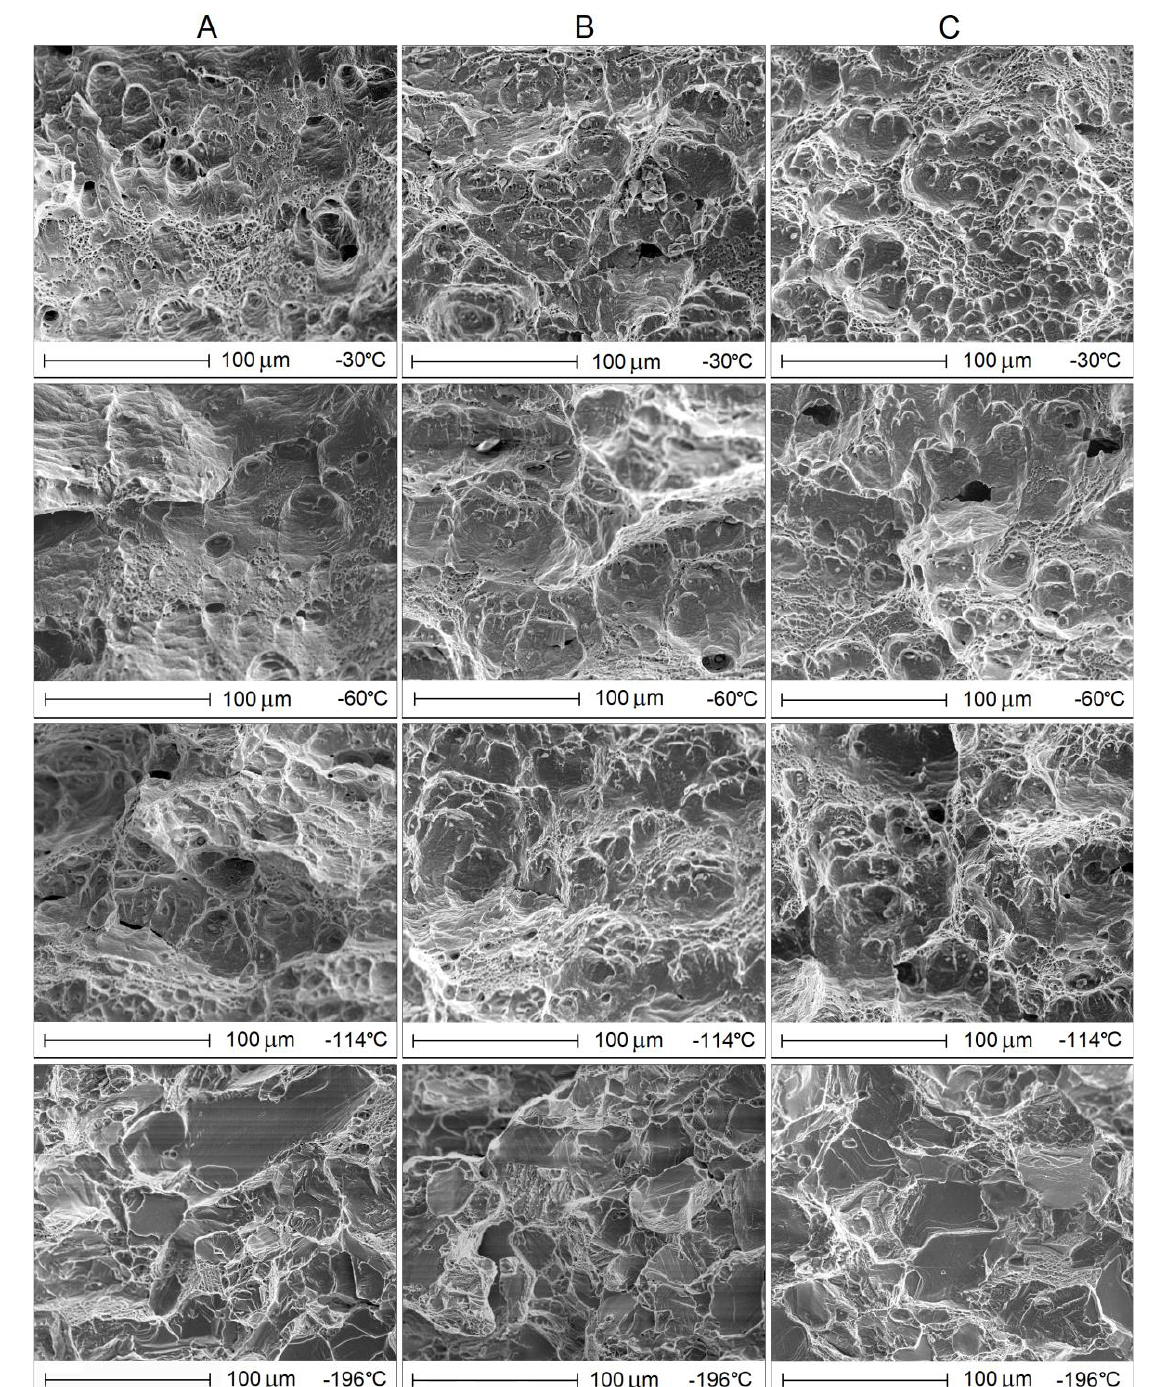
Figure 10. The fracture surfaces of the Charpy specimens after the impact bending tests at T = − 30 ◦ C, T = − 60 ◦ C, T = − 114 ◦ C, and T = − 196 ◦ C ( A – C